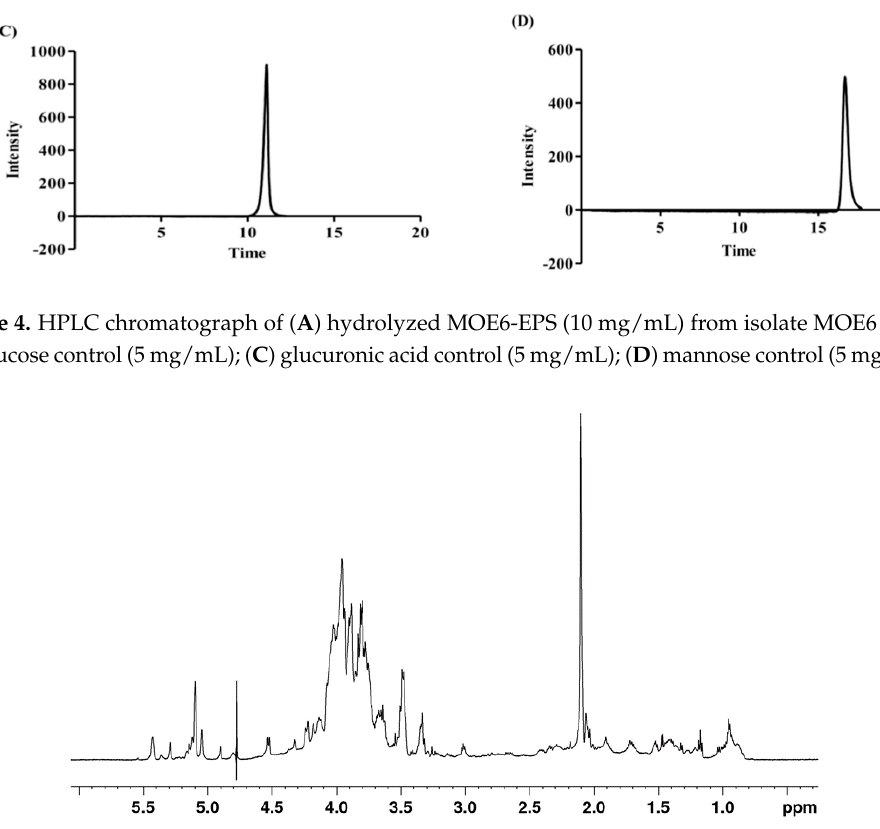
Figure 5. Proton NMR spectrum of 5 mg of MOE6-EPS dissolved in 0.75 mL D 2 O.